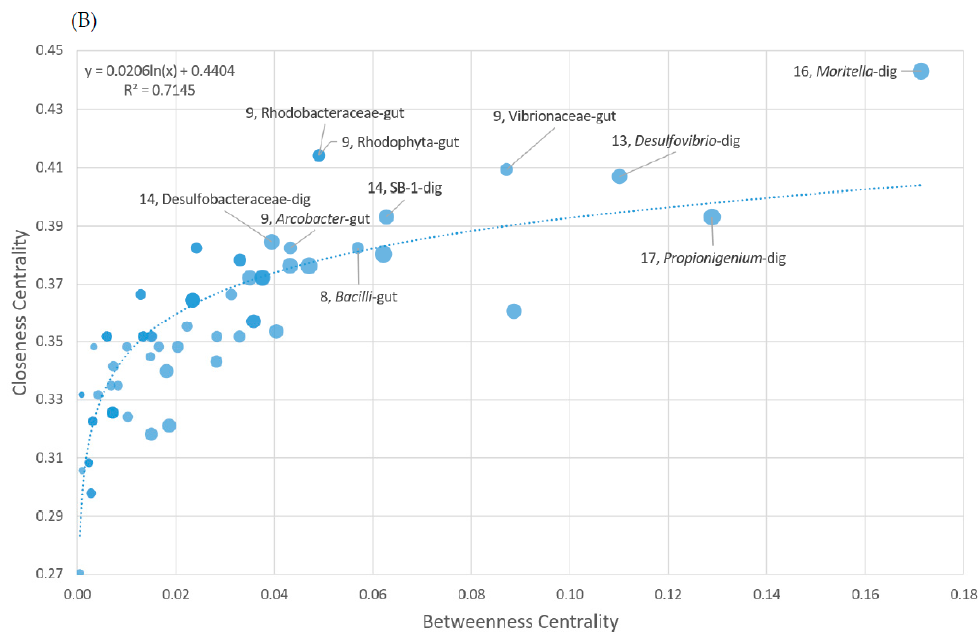
Figure 10. Co-occurrence patterns between taxonomic entries of the gut tissue and gut digesta, determined through Co-occurrence Network inference (CoNet v1.1.1), and analyzed through Cytoscape (v3.6.0). Taxonomic entries with a cumulative row sum of 200 or above with 2/3 of samples showing non-zero value entries were used through an ensemble approach that incorporated the Pearson, Spearman, Bray–Curtis, Kullback–Leibler, and mutual information metrics. The top and bottom 200 edges were selected and merged by the union method. ( A ) The network analysis shows the edges represented by the q-value (merged with the Brown method at p < 0.05 for each metric) and are shown as green (co-presence) and red (co-exclusion), with the nodes representing taxa were scaled according to relative abundance and colored according to the phyla (class for Proteobacteria) assignments. The final network was arranged using the yFiles (v1.0) Cytoscape (v3.6.0) add-on radial layout, and taxonomic entries shown at the highest resolution are denoted with the sample type (circle for gut tissue, “-gut”; diamond for gut digesta; “-dig”). The network has been generated using scalable graphics, and therefore nodes of interest can be viewed at a higher resolution digitally by increasing the magnification. ( B ) Scatter plot analysis was performed using topological metrics determined by NetworkAnalyzer (v2.7), to demonstrate patterns of key (keystone) species between taxonomic entries of the gut tissue and gut digesta based on closeness and betweenness centrality, as well as the degree (number of co-presence and co-exclusion edges). Linear regression between closeness and betweenness centrality was shown as logarithmic (R 2 value = 0.7145), and the top 10 entries ranked by closeness centrality are depicted. Note, the taxa Rhodophyta and Rhodobacteraceae had the same closeness and betweenness centrality measurements, and their corresponding plot is indistinguishable. Linear regression determined through Microsoft Excel Software (Seattle,